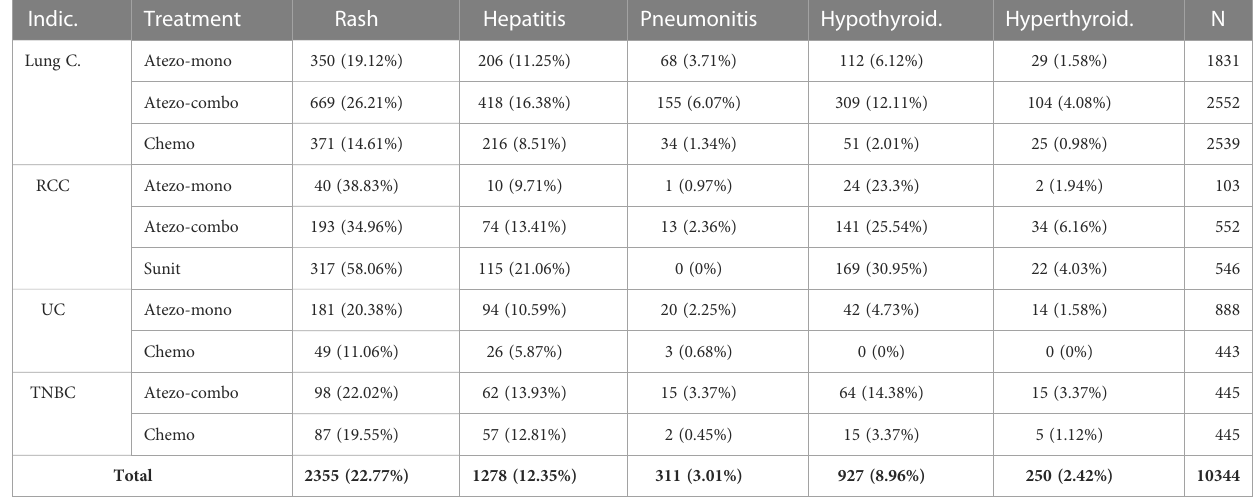
TABLE 2 Frequencies of irAEs (rash, hepatitis, pneumonitis, hypothyroidism, hyperthyroidism) of any grade per indication and treatment arm (atezolizumab monotherapy, atezolizumab combination, standard of care/control arms [chemotherapy or targeted therapy]).